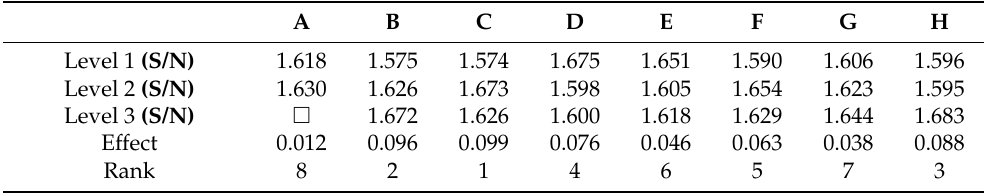
Table 7. Effect Response Table.